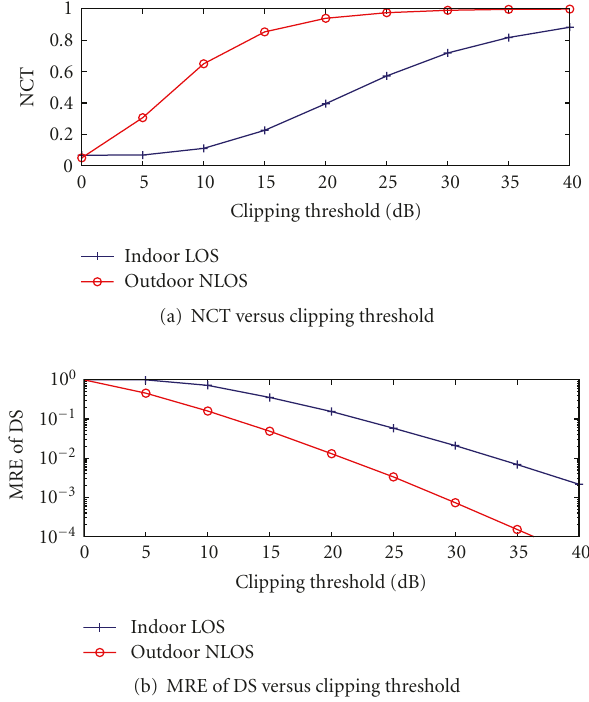
Figure 2: The impact of clipping threshold on the e ffi ciency and the accuracy (averaged over 10 4 -drop